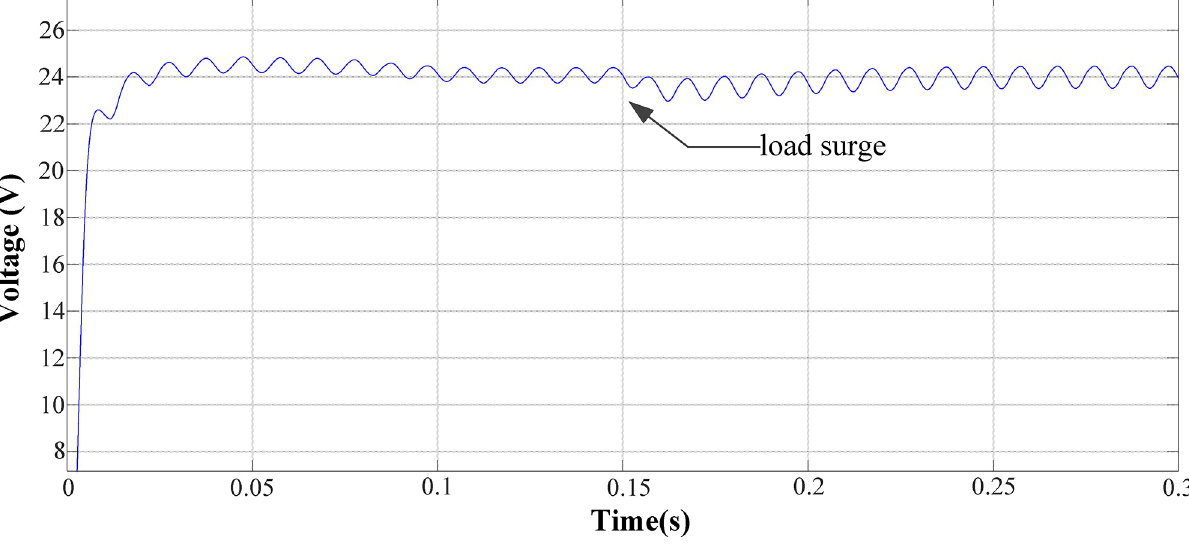
Fig 10. System output voltage waveform under load